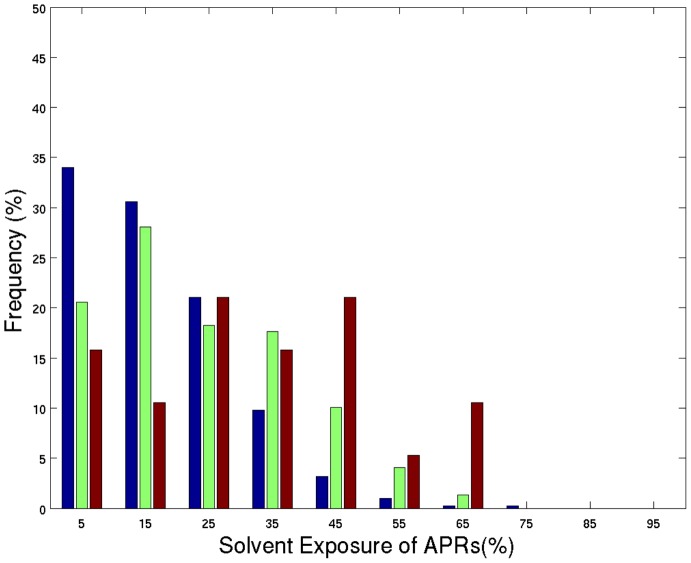
Solvent exposure presented in a bar plot for all 409 TANGO predicted APRs (blue bars), 516 WALTZ predicted APRs (green bars), and 19 Amylsegs (red bars) in the crystal structures of monomeric proteins from F495.X-axis shows the percent solvent accessible surface area and Y-axis indicates frequency of APRs and Amylsegs. On average, TANGO and WALTZ predicted APRs show lower solvent exposures compared to the Amylsegs.